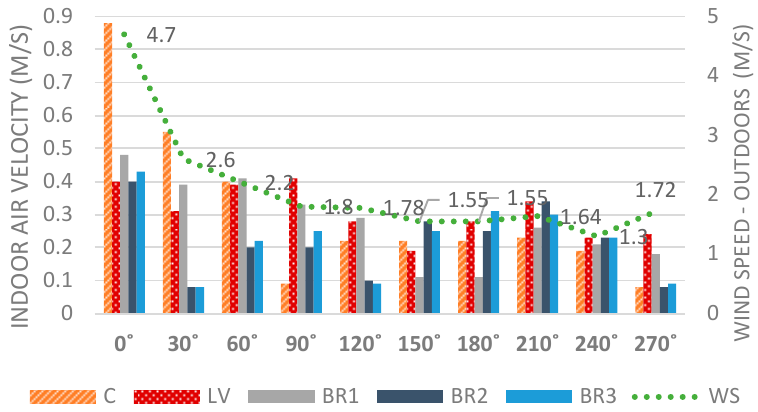
Figure 13. Average indoor air velocities (m/s) across the spaces calculated at a horizontal plane at 1.2 m above the floor for different incident wind directions. The wind direction’s influence on the air flows and the predicted air velocities can be observed in Figure 14. The image combines the distribution of normalized mean wind speed U norm (the mean wind speed values were rescaled to have mean = 0 and standard deviation = 1) and streamlines patterns around the ground and first floor. For the sake of space, only the three most frequent incident wind directions ( θ = 150°, 180°, 210°) and the highest speed ( θ = 0°) are portrayed. Both predicted U norm and streamlines vary significantly with incident wind directions in terms of eddies’ existence, size, and position in the rooms. Depending on the incident wind angle, the flows in space may present either a pattern from a cross-ventilated room, with a more uniform distribution (Figure 14c,e, or of a single-sided one, showing eddy formations in the room corners (Figure 14a,g). Moreover, higher indoor air velocities are observed when the building orientation is oblique to an incident wind angle. The case with the south wind ( θ = 180°), for example, perpendicular to the building’s openings (Figure 14e,f)), presents lower air velocity values than the oblique one, with the south-southwest direction ( θ = 210°) (Figure 14g,h), alt- hough both have the same inlet wind speed of 1.55 m/s. While the bedrooms 1 and 2 show air velocities of 0.11 and 0.25 m/s for θ = 180°, when θ = 210°, the values are 0.26 and 0.34 m/s, respectively. This influence of the building orientation concerning the wind incident angle is also observed in [18].